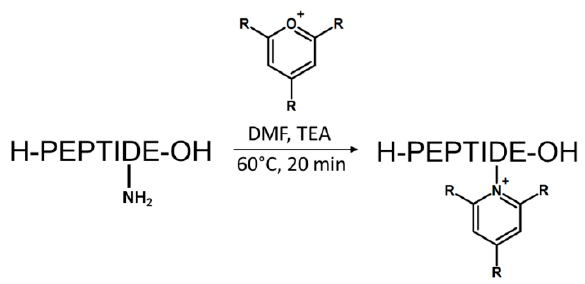
Figure 12. Reaction of peptide with 2,4,6-trisubtituted pyrylium salt (R*-alkyl or aryl).